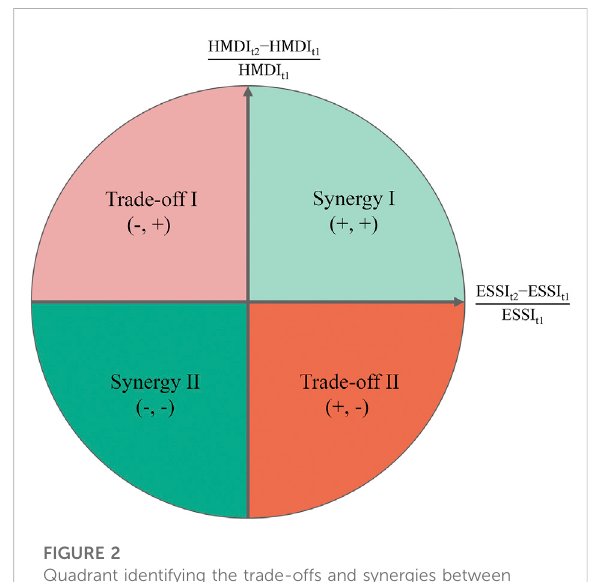
FIGURE 2 Quadrant identifying the trade-offs and synergies between ecosystem services and human